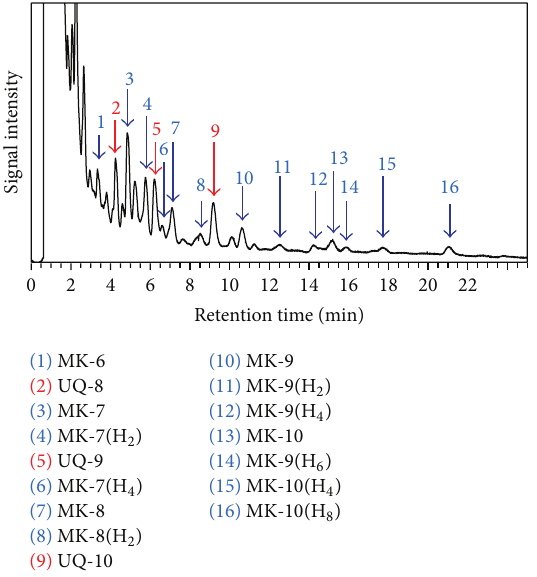
Figure 4: Chromatogram of quinones obtained from compost by SFE and UPLC. Sample amount: 0.3 g dried compost. SFE con- ditions: 45 ∘ C; 25 MPa; 15 min; 90% CO 2 -10% methanol with flow rate of 1mLmin −1 . UPLC conditions: column: 2.1 × 30 mm, 1.7 𝜇 m Acquity BEH C18 at 35 ∘ C; methanol mobile phase at flow rate of 0.3 mLmin −1 ; 10 𝜇 L sample injection volume, PDA.